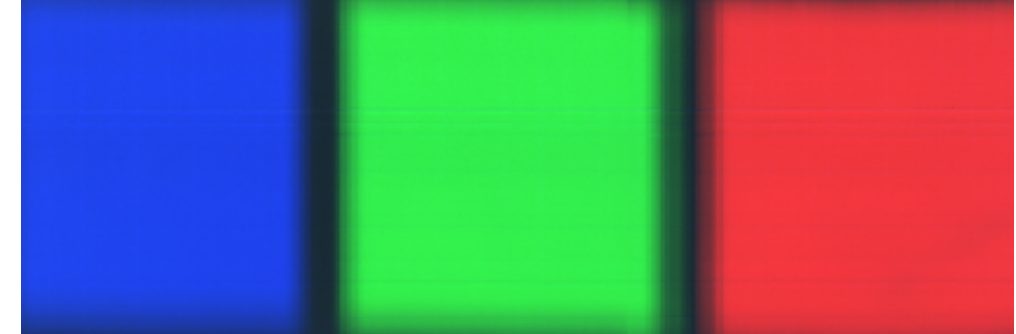
Figure 7. False color image constructed from the scan of the color checker. Scanning direction was from right to left. Blurry edges between the color tile boundaries are caused by uneven scanning speed of the manually driven scan. Vertical shift in the green tile is due to losing connection to the desk during the